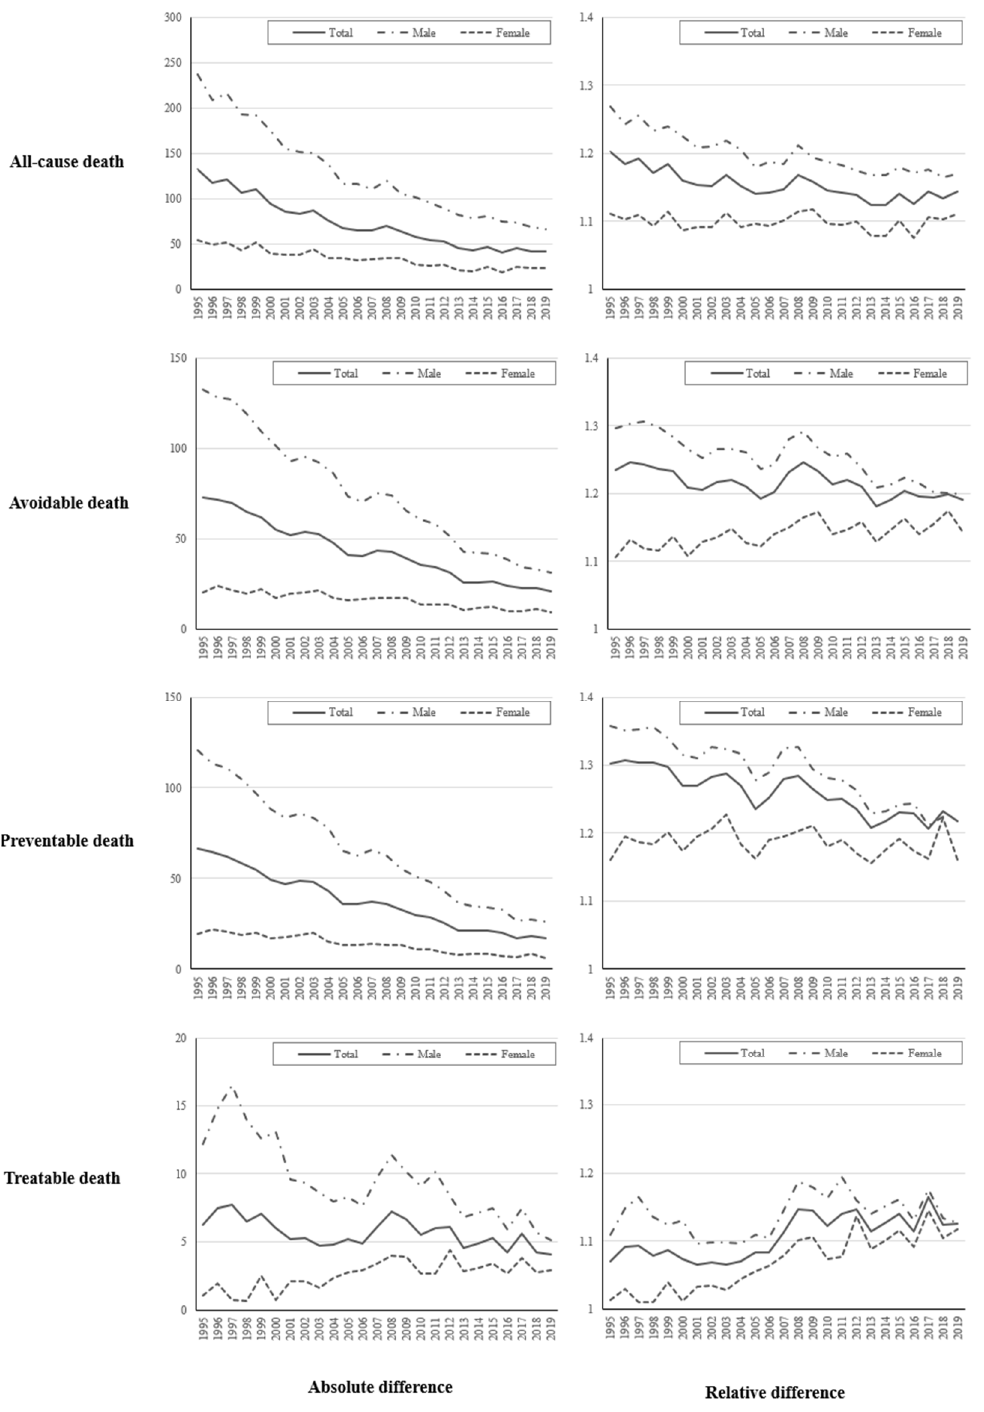
Figure 2. Absolute and relative differences of all-cause, avoidable, preventable, and treatable mortality between metropolitan and non-metropolitan areas from 1995 to 2019.